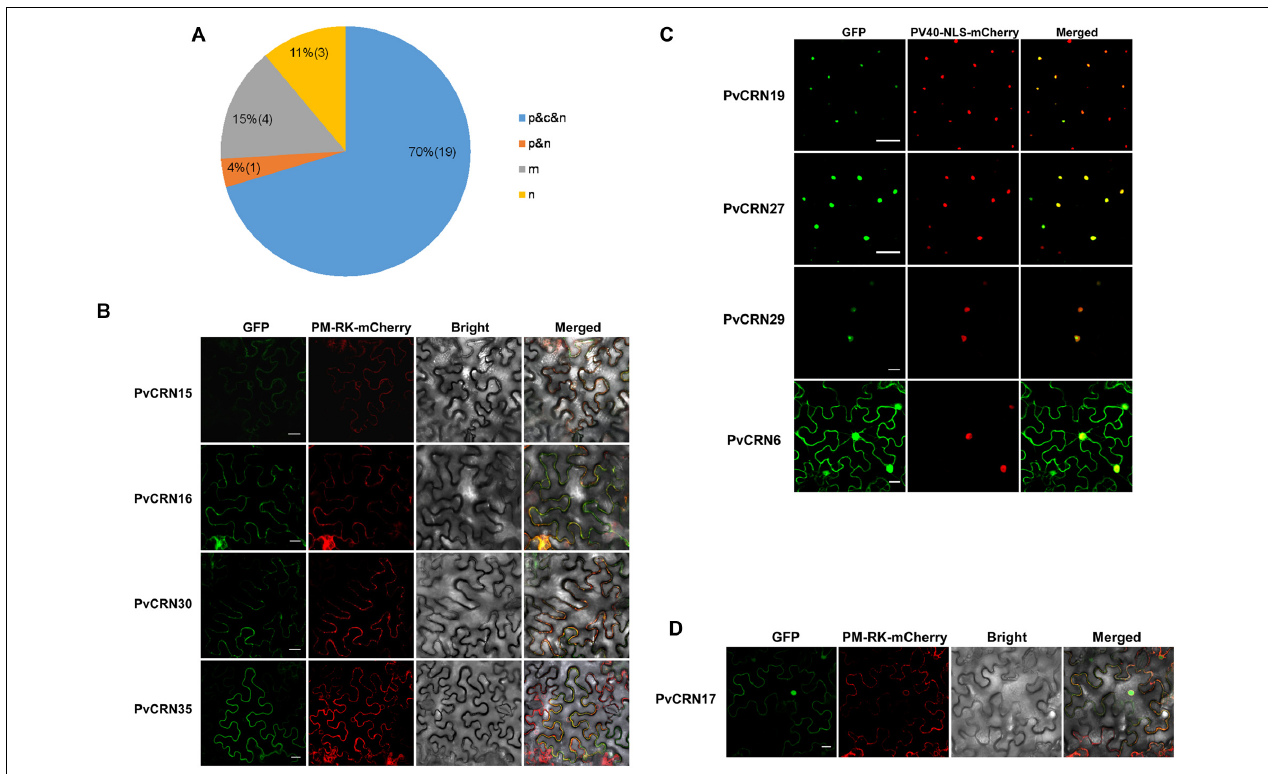
FIGURE 4 | PvCRN proteins are distributed among different plant cell compartments. PvCRN proteins labeled with GFP were transiently expressed in N. benthamiana leaves to determine their subcellular localization in the plant cell by confocal microscopy at 48–72 h post agroinfiltration. p, plasma membrane; c, cytoplasm; n, nucleus; m, membrane. (A) A summary of statistics of subcellular localizations of PvCRN proteins. (B) PvCRN15, PvCRN16, PvCRN30, and PvCRN35 were localized in the membrane system of the host cell, and PM-RK was used as a membrane localization marker. (C) PvCRN19, PvCRN27, and PvCRN29 were localized in the nucleus of the plant cell. PvCRN6 was one of the PvCRN proteins that were localized in the plasma membrane, cytoplasm, and nucleus of the plant cell. (D) PvCRN17 was distributed among both the plasma membrane and nucleus of the plant cell. The scale bar indicates 20 µ m.